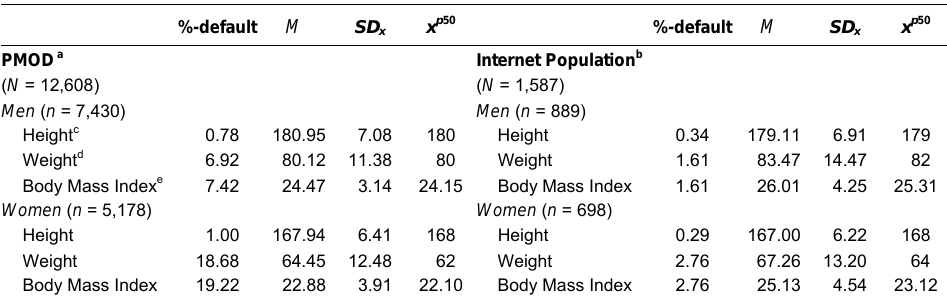
Comparison of online daters’ height, weight, and BMI with the height, weight, and BMI of the German Internet